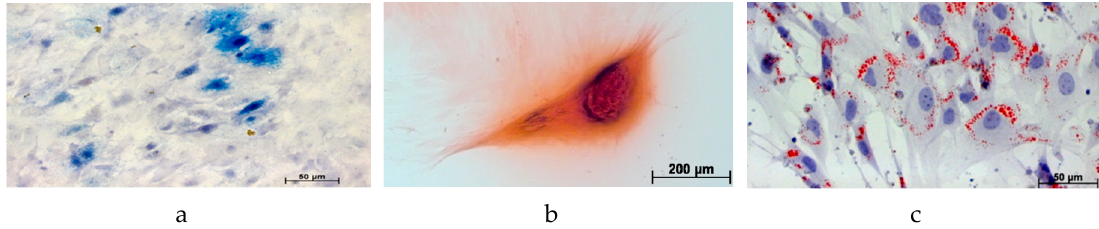
Figure 1. Differentiation of the USSC into the three lines. ( a ) osteogenic differentiation, alkaline phosphatase; ( b ) chondrogenic differentiation, safranin O; ( c ) adipogenic differentiation, oil red